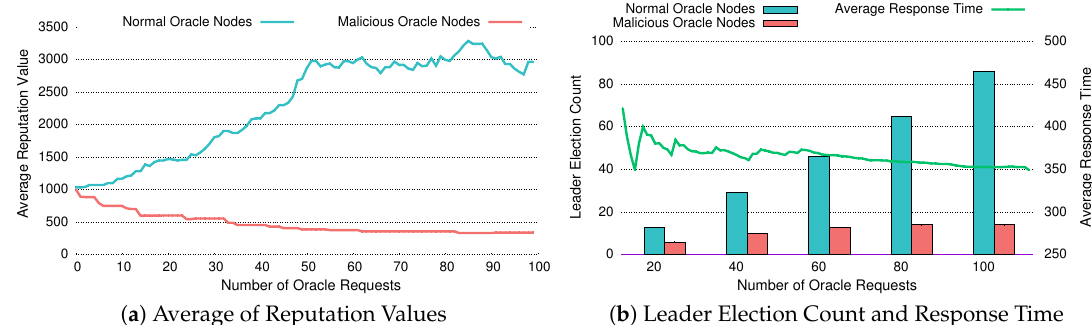
Figure 12. Evaluation of Reputation with 200% Response